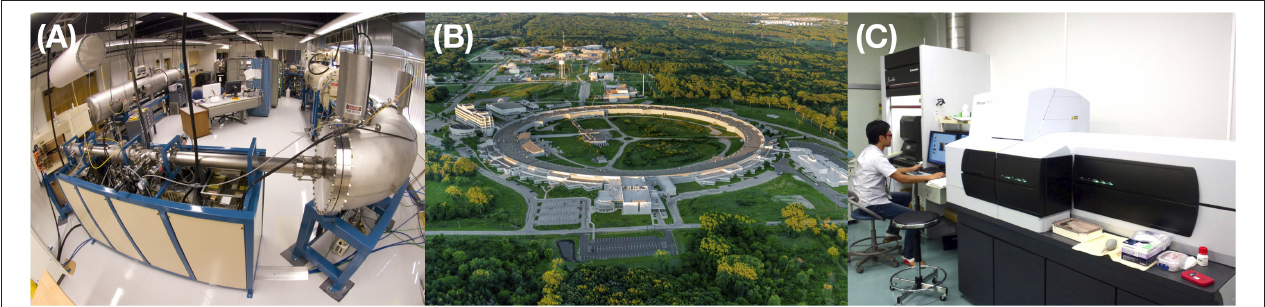
FIGURE 2 | Example techniques that greatly enhance life detection but cannot be flown. (A) Secondary Ion/Accelerator Mass Spectrometer for isotopic measurements on small samples proximal to surface contamination, built and used for the Genesis mission. Credit: NASA (public domain). (B) Aerial view of a synchrotron X-ray source used, e.g., for microscale X-ray diffraction. Credit: Argonne National Laboratory, reproduced under a CC BY-NC-SA 2.0 license. (C) Matrix-Assisted Laser Desorption/Ionization (MALDI)-Imaging Mass Microscope. Credit: